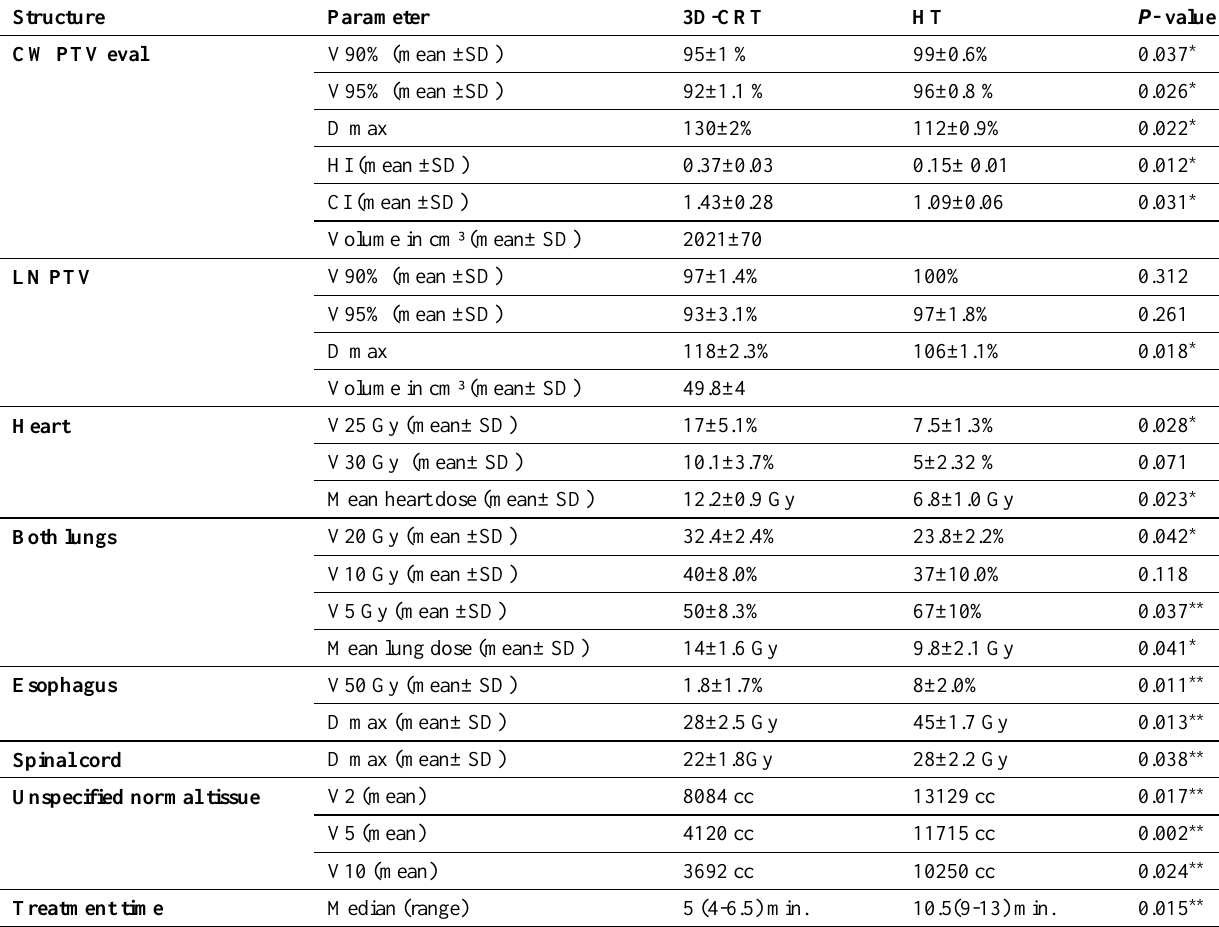
Table 3: Comparison between the 2 techniques regarding PTV coverage and doses to OARs